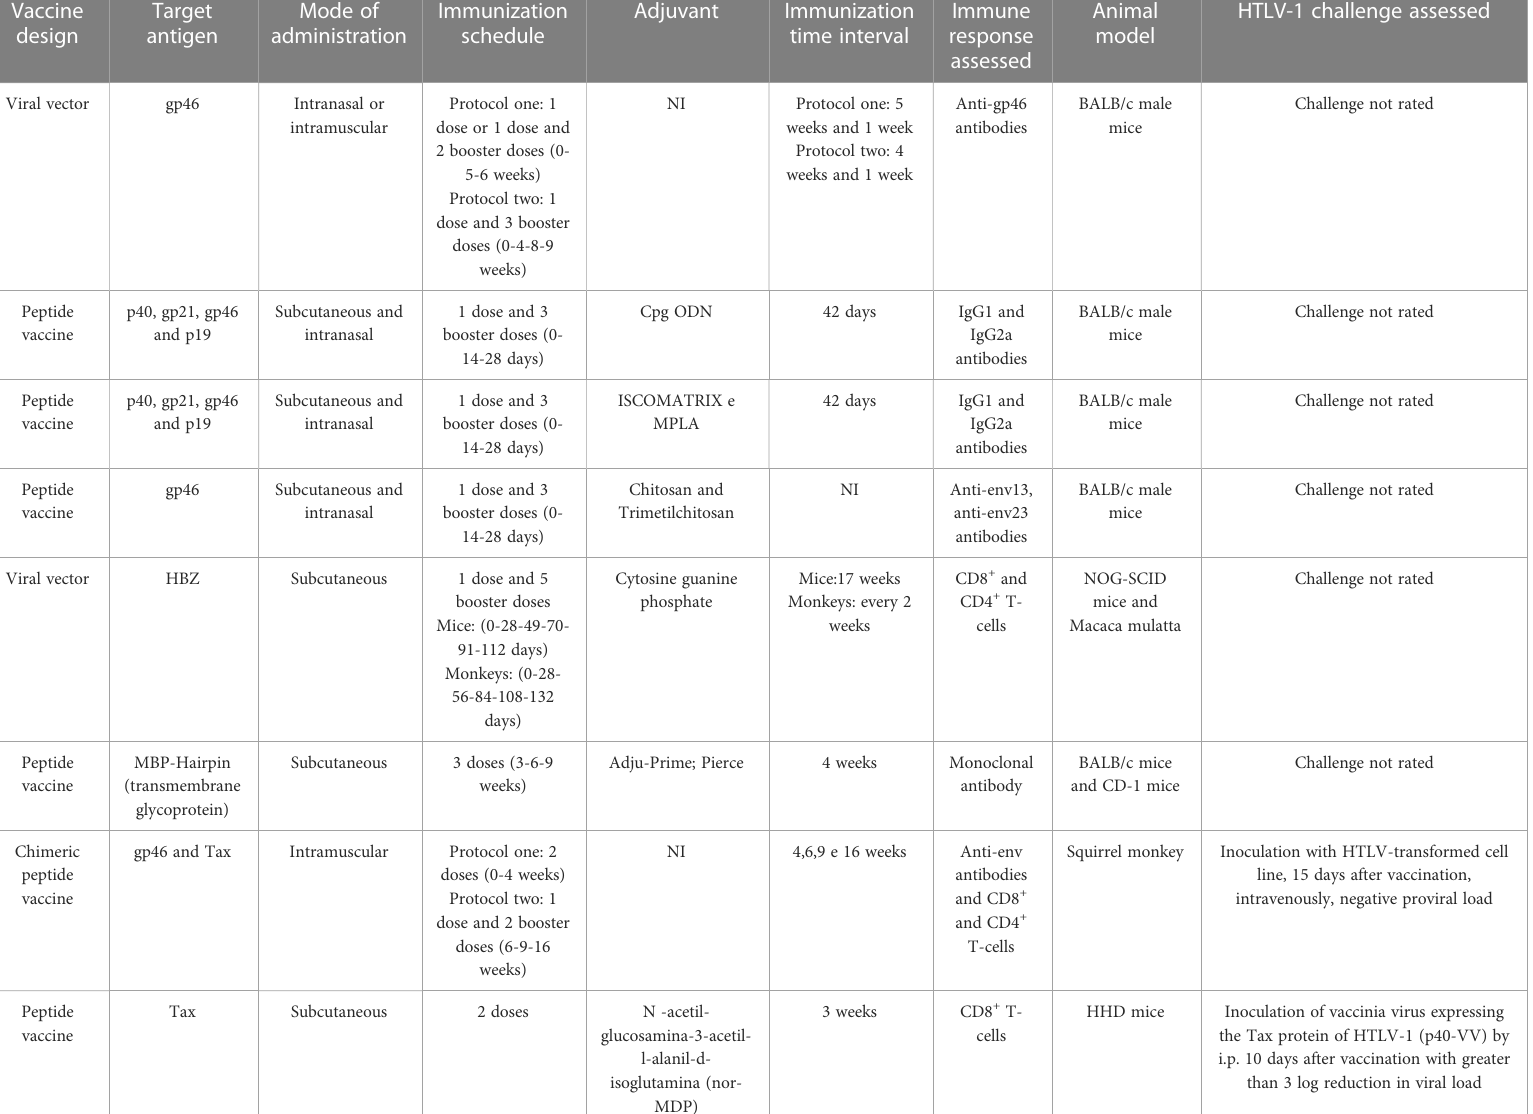
Protocol one: 5 weeks and 1 week Protocol two: 4 weeks and 1 week